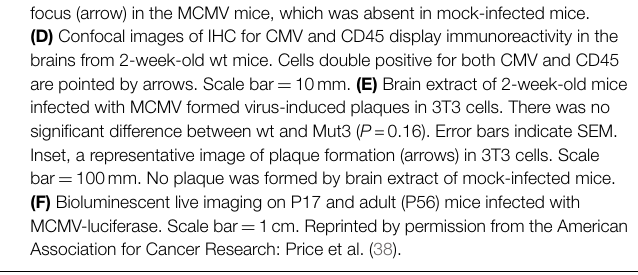
FIGURE 2 | Perinatal MCMV infection shortens the survival of Mut3 mice . (A) Kaplan–Meier curves display overall (left) and histologically glioma-confirmed (right) survivals of Mut3 mice. Labels indicate infection groups, mouse numbers, mean survival time, and P values against mock and HSV1 (first and second P values, respectively). (B) Left, a representative hematoxylin and eosin (H&E)-stained brain section from an MCMV-infected Mut3 mouse that harbors a